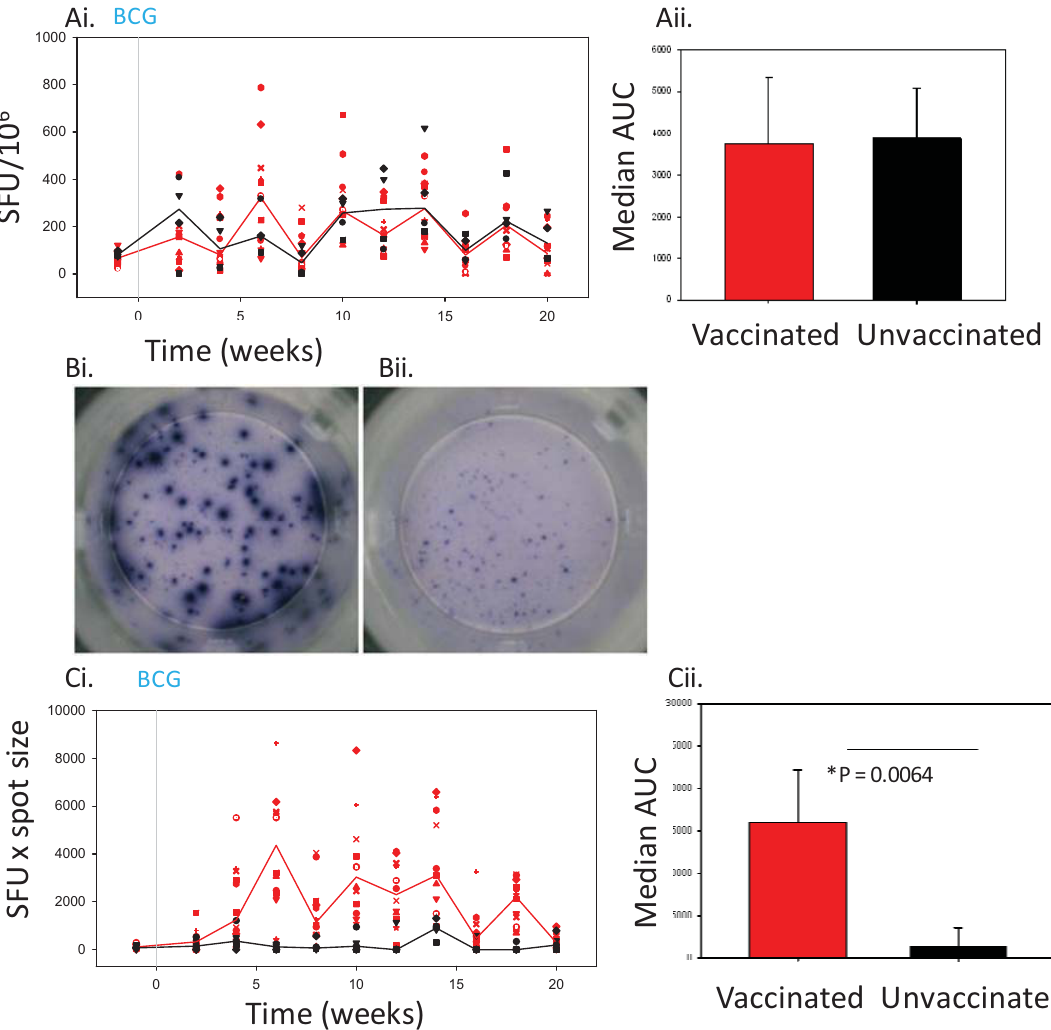
Figure 1. The IFN(cid:2) response to Mycobacterium bovis Bacille Calmette Guerin (BCG) vaccination in Mauritian cynomolgus macaques measured by ELISPOT. Panel A shows the frequency of purified protein derivative (PPD)-specific IFN-(cid:2) secreting cells in peripheral blood mononuclear cells (PBMC) measured as spot forming units (SFU)/10 6 in individual BCG vaccinated n = 16 (red symbols) and unvaccinated n = 4 (black symbols) macaques and the median response in each group (BCG vaccinated group, red line, unvaccinated group, black line) ( Ai ) and the median area under the SFU curve (area under the curve (AUC)) calculated for the BCG vaccinated (red bar) and unvaccinated (black bar) study groups and compared using a Mann Whitney test ( Aii ). Panel B shows images of spots which developed in wells containing PBMC stimulated with PPD from a BCG vaccinated macaque ( Bi ) and an unvaccinated macaque ( Bii ). Panel C shows the IFN(cid:2) response profiles determined using spot size x quantity from individual BCG vaccinated (red symbols) and unvaccinated (black symbols) macaques and the median response in each group (BCG vaccinated group, red line, unvaccinated group, black line) ( Ci ), and the median area under the spot size x quantity curves (AUC) calculated for BCG vaccinated (red bar) and unvaccinated (black bar) study groups and compared using a Mann Whitney test ( Cii ). Ai. Aii.